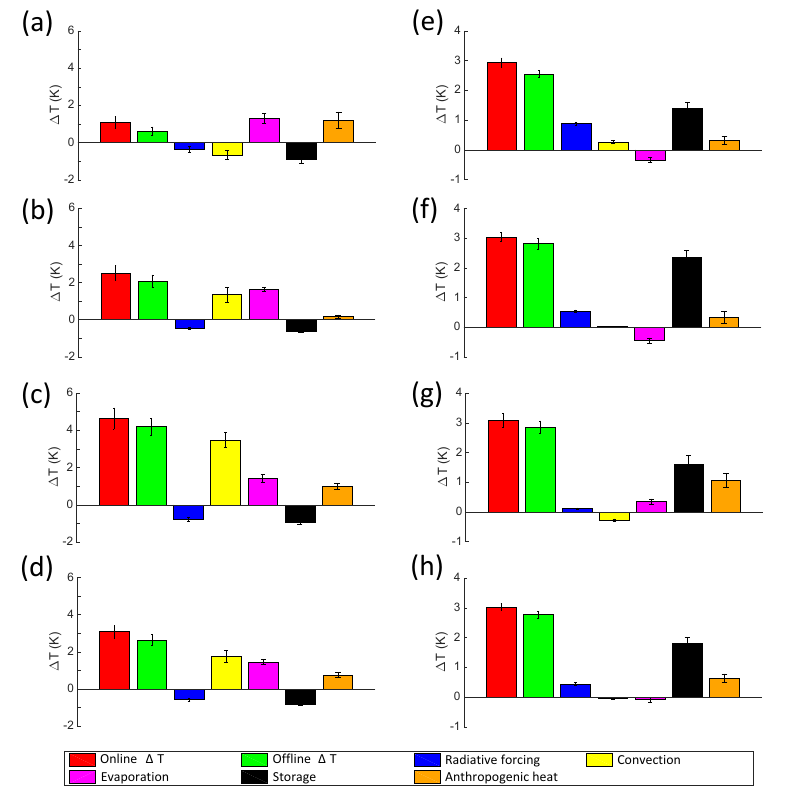
Figure 1. Attribution of summer mean UHI intensity during 2071–2100 under the RCP 4.5 scenario for the control (CTR) run. (a, b, c, d) daytime; (e, f, g, h) nighttime. (a, e) dry climate; (b, f) continental climate; (c, g) temperate climate; (d, h) all selected cities. The radiative forcing term results mostly from albedo differences between urban and rural land in the daytime and from small differences in surface emissivity at night. Error bars are ± 1 standard